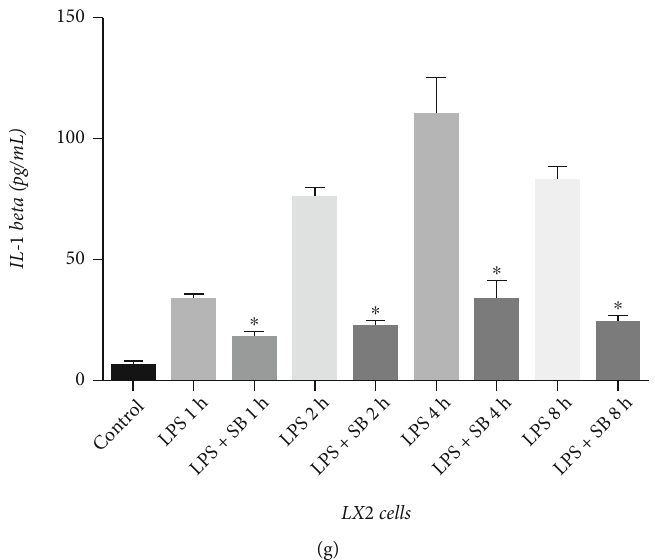
Figure 3: LPS promotes in fl ammation via p38 MAPK in HSCs. (a – c) THP-1 cells in the logarithmic growth phase were treated with 1 μ g/mL LPS for 15min for the detection of p38 MAPK or for 4h for the detection of in fl ammation. (d) LX-2 cells in the logarithmic growth phase were treated with 1 μ g/mL LPS in a time-dependent manner (0-8h). (e – g) LX-2 cells in the logarithmic growth phase were treated with or without 20 μ M SB203580 for 30min, then cells were treated with 1 μ g/mL LPS for 15min for the detection of p38 MAPK or in a time-dependent manner (0-8h) for the detection of in fl